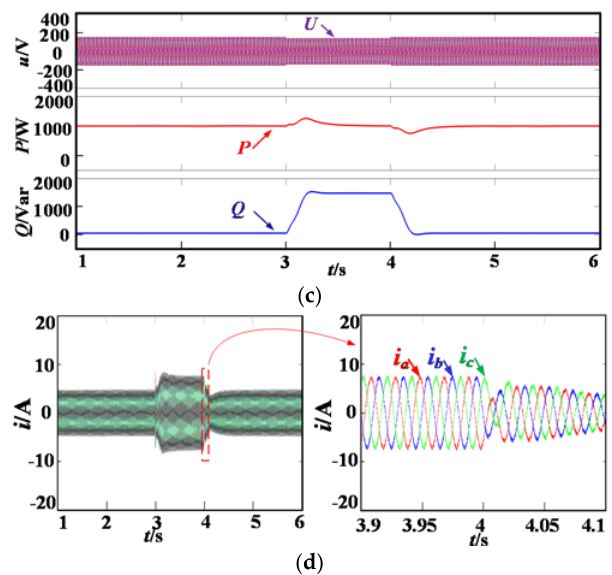
Figure 9. Voltage ‐ variation influence on parameters when wind speed is constant. ( a ) Wind speed, Figure 9. Voltage-variationinfluenceonparameterswhenwindspeedisconstant. ( a )Windspeed, torque, torque, turbine speed and DC ‐ link voltage; ( b ) generator ‐ side three phase current, current local turbine speed and DC-link voltage; ( b ) generator-side three phase current, current local magnification; magnification; ( c ) voltage, active and reactive power; ( d ) grid ‐ side three phase current, current local ( c ) voltage, active and reactive power; ( d ) grid-side three phase current, current local magnification. magnification.